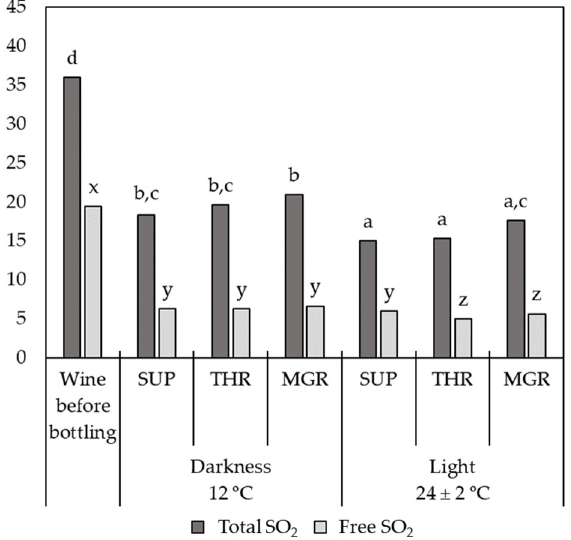
Figure 1. Total and free SO 2 levels (mg/L) in Verdejo wines before bottling and those storage for one year under the different conditions tested. SUP: super quality natural corks; THR: third quality natural corks; MGR: microgranulated corks. Different letters (a,b,c,d or x,y,z) in the same variable mean significant differences ( α = 0.05) according to the test of Student–Newman–Keuls.